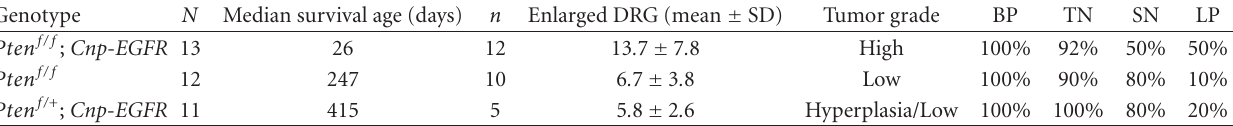
Table 1: Occurrence of di ff erent peripheral nervous system phenotype detected in various experimental and control cohorts. Genotype N